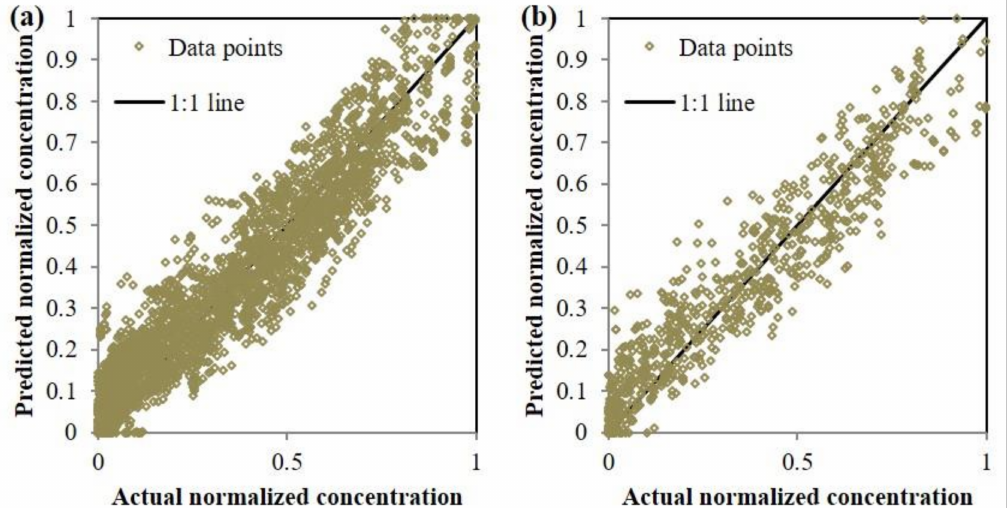
Figure 6. Comparison of the actual and predicted normalized concentration: ( a ) training dataset, and ( b ) testing